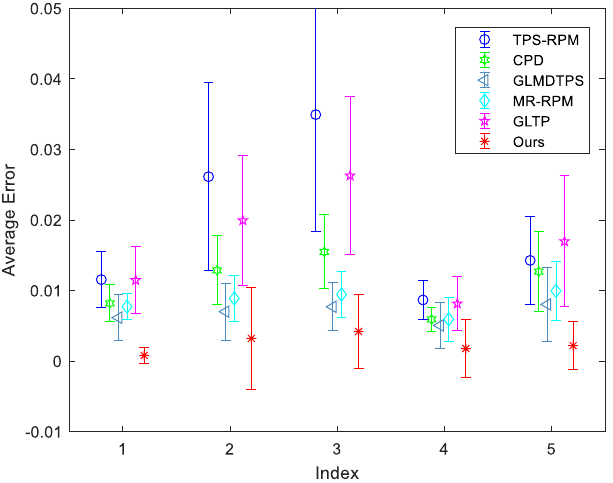
Figure 6. Quantitative comparisons of TPS-RPM, CPD, GLMDTPS, MR-RPM, and GLTP and the proposed method on IMM face dataset. From Group 1 to Group 5, they represent the registration results between view 1 and view 2 to view 6, respectively. The error bars indicate the mean and standard deviation of registration errors over 40 trials.